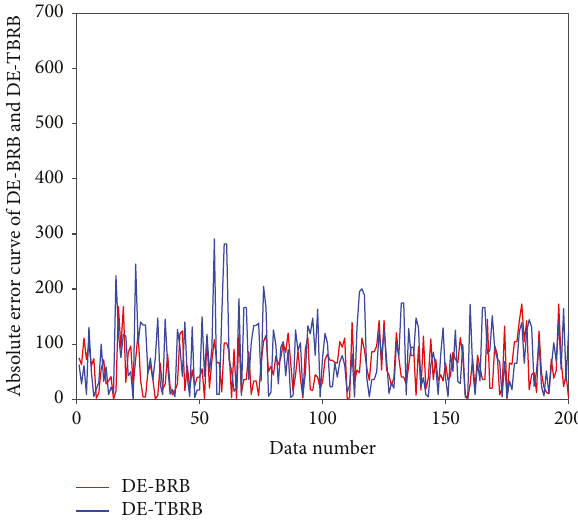
Figure 11: The absolute error of DE-BRB and DE-TBRB.